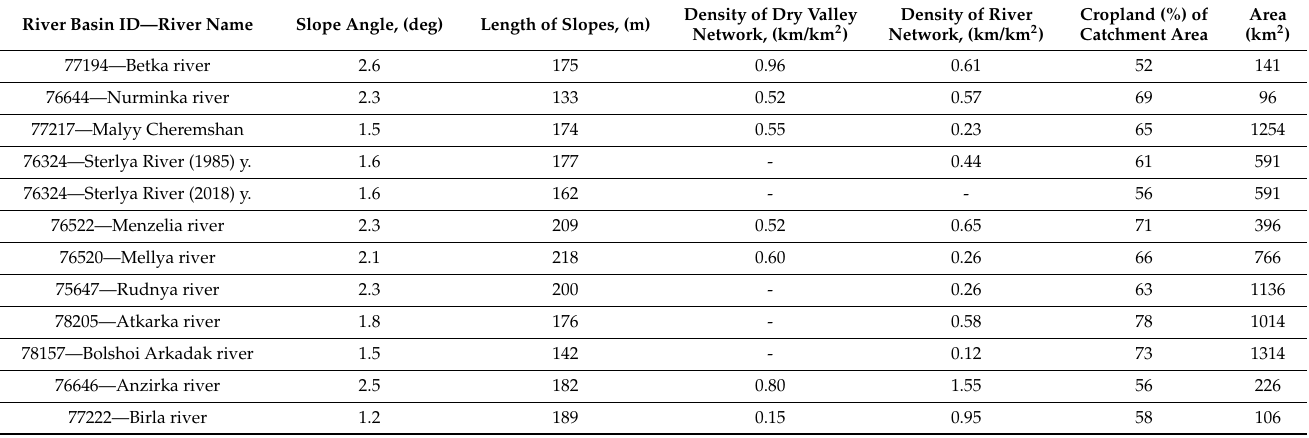
Table 2. Relief and land use characteristics of test river basins affect the mass of formed sediment and its